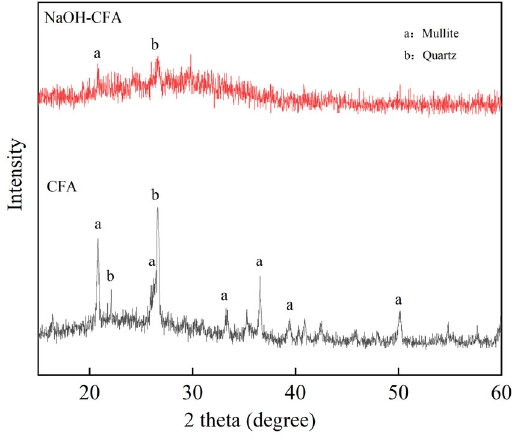
Figure 6. XRD diffractograms of CFA and NaOH ‐ CFA.